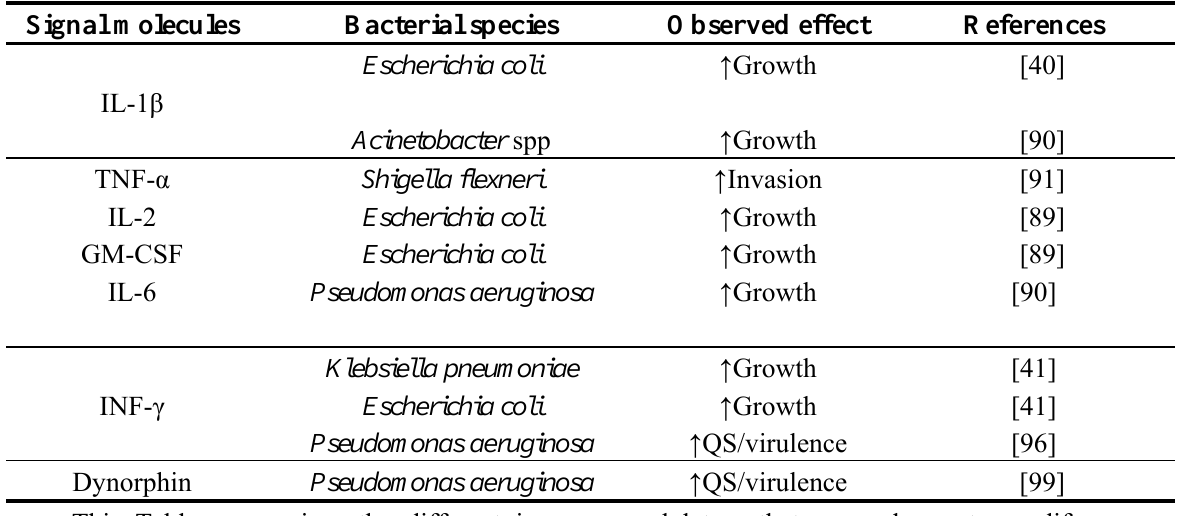
Table 2. Immune modulators and